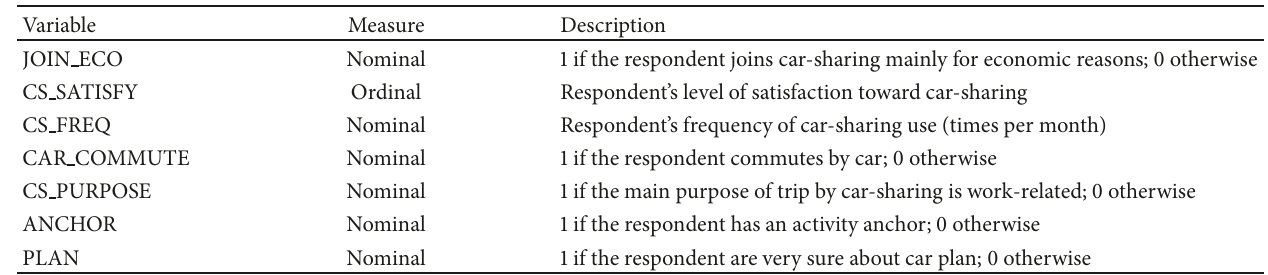
Table 10: Descriptions of significant variables in the binominal logit model.